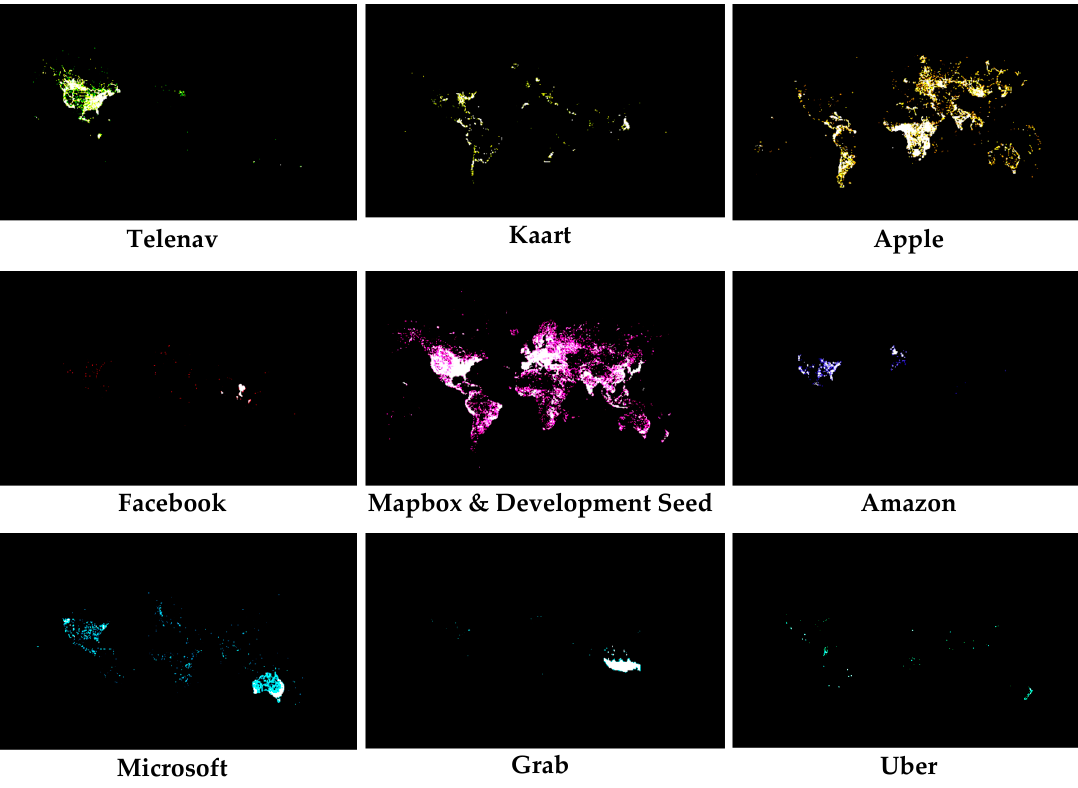
Figure 3. Where corporate editors are editing. The main map shows an aggregated view for all 10 companies. The sub figures show where each company is editing. In this map, we have combined the Mapbox and Development Seed teams because they merged in late